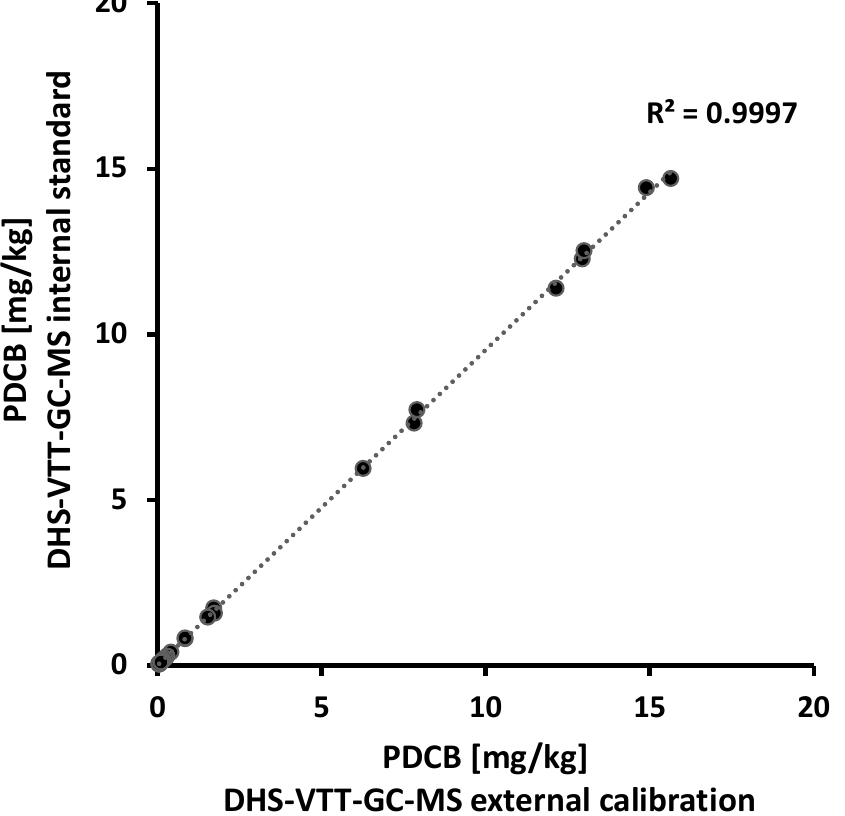
Figure 1. Determination of the PDCB concentration in wax samples (N = 34) by DHS-VTT-GC-MS. Quantitation was achieved through external calibration (x-axis) versus calculation of the PDCB concentration using the internal standard PDCB-d4 (y-axis).